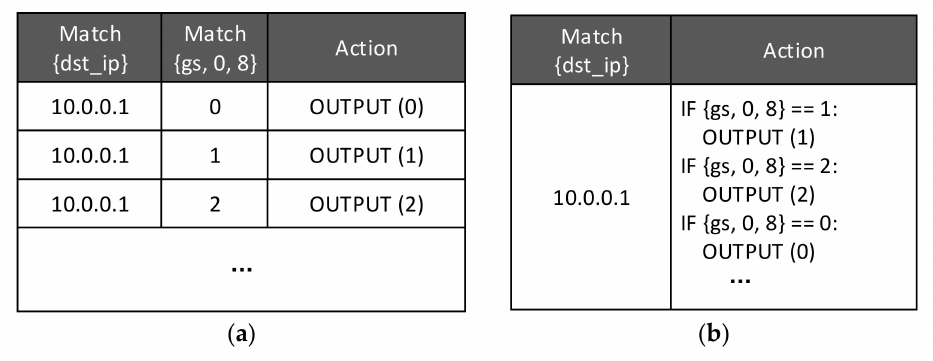
Figure 13. Two state-comparison methods. ( a ) Compare state with match fields. ( b ) Compare state with actions.